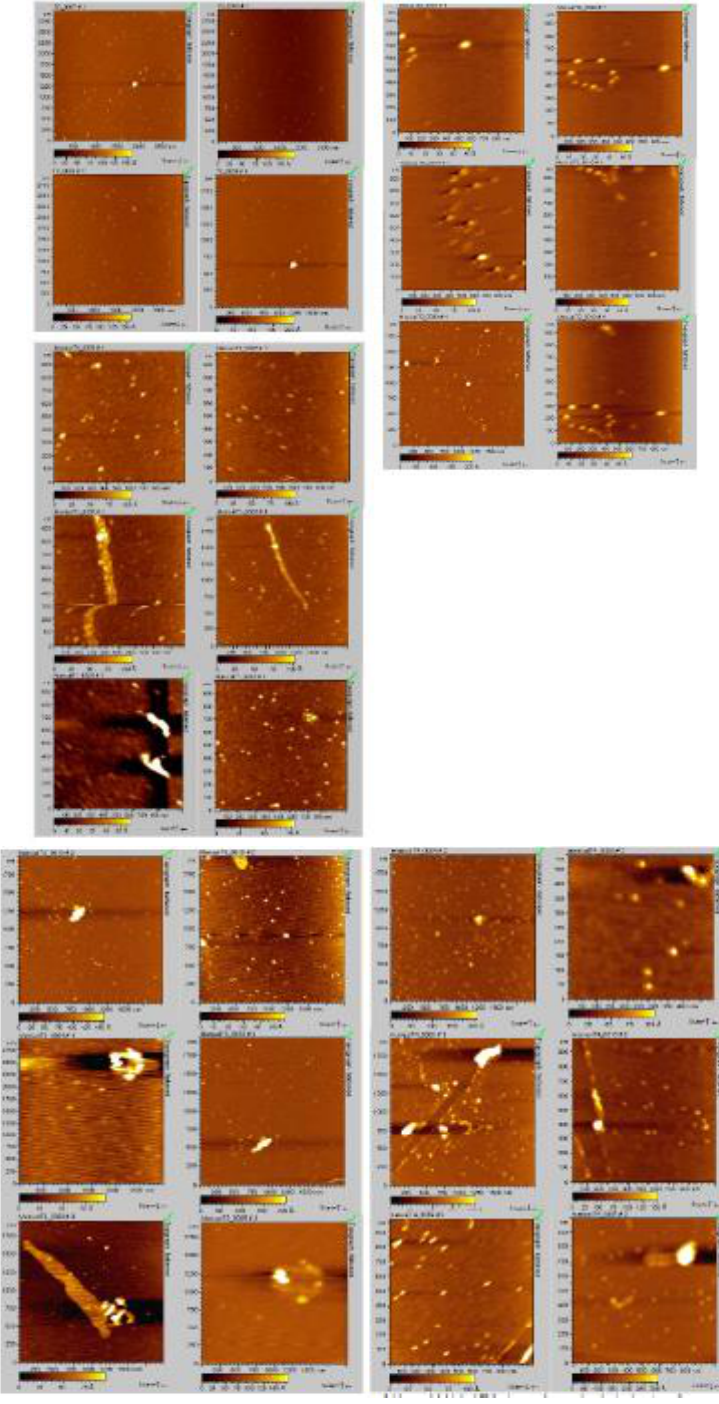
Figure 8. AFM micrographs obtained at time of rotenone addition: four images, upper left corner, 0 h; six images, upper right corner, 15 min, right; six images, middle left side, 30 min; six images, bottom left corner, 1 h; six images, bottom right corner, 3